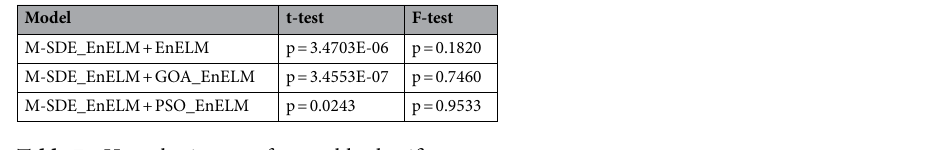
Table 7. Hypothesis tests of ensemble